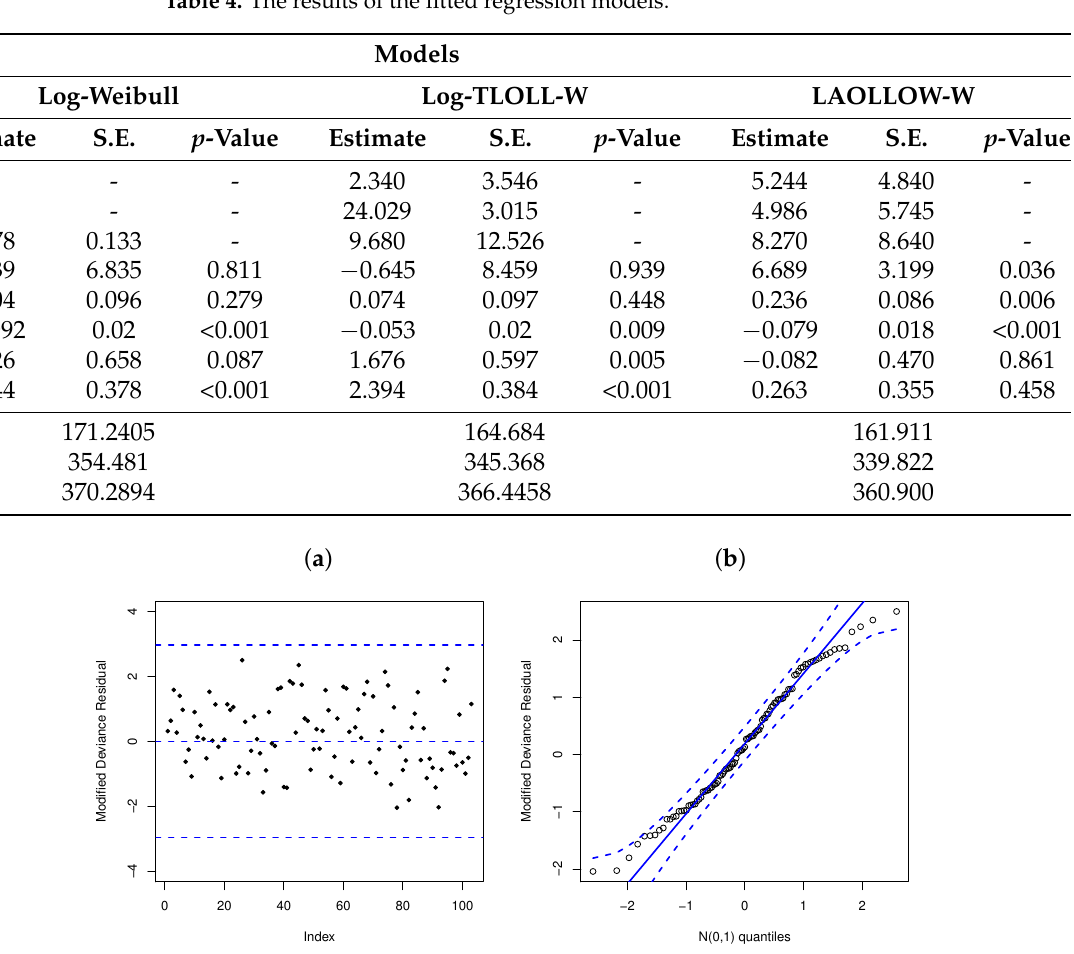
Table 4. The results of the fitted regression models.